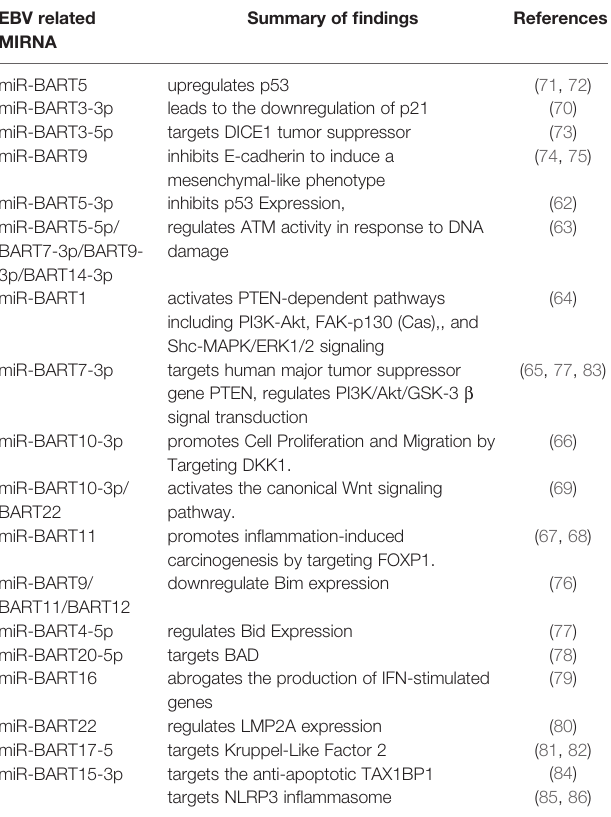
TABLE 2 | Summary of EBV-miRNAs expressed during gastric cancer pathogenesis.